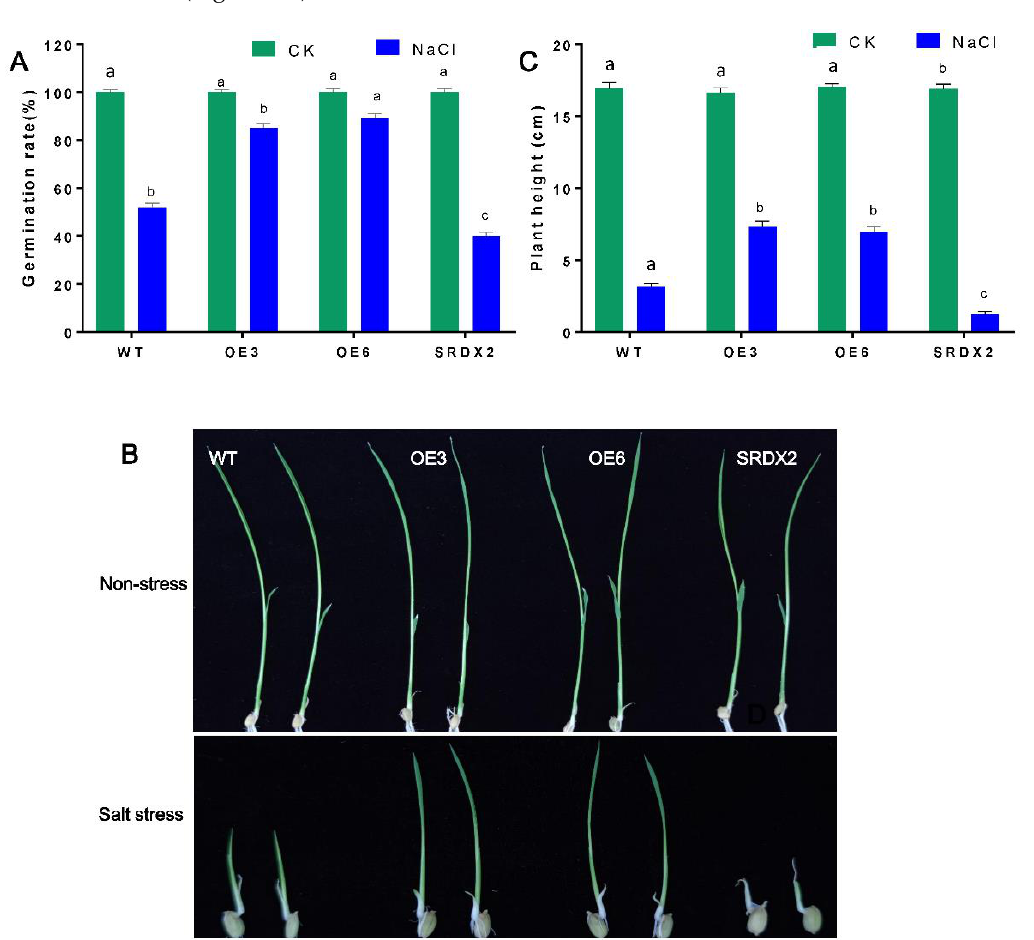
Figure 4. Responses of seed germination and seedling growth to NaCl treatment. ( A ) Germination rates: seeds of transgenic lines and WT were soaked in distilled water for 1 day and then scattered on a 1/2 MS medium with 100 mM NaCl for 5 days. ( B ) Phenotypes: seeds were placed in distilled water for 2 days, and then transferred to a 1/2 MS solution containing 150 mM NaCl for 14 days. Mean and SD are shown (n = 20). ( C ) Shoot height of the seedlings in ( B ). Statistical analyses were performed by a two-way ANOVA, followed by a Tukey’s multiple comparison test. Different letters indicate significant differences at p < 0.05.